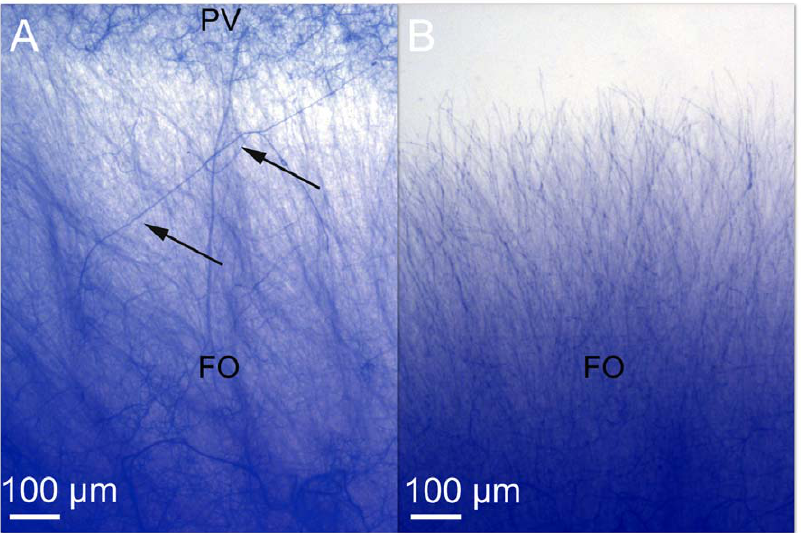
Figure 3. Observation by optic microscopy of the mycelium of F.oxysporum in dual culture or single culture. (A) F. oxysporum hyphae from dual culture with the endophyte. (B) F. oxysporum hyphae control. (PV) P. variabile and (FO) F.oxysporum . Optic micrographs of the mycelium of F. oxysporum from dual culture or single on agar plate with the endophyte P. variabile (14 days, 27 u C). Arrows show disorganization of the hyphae in the presence of the endophyte.